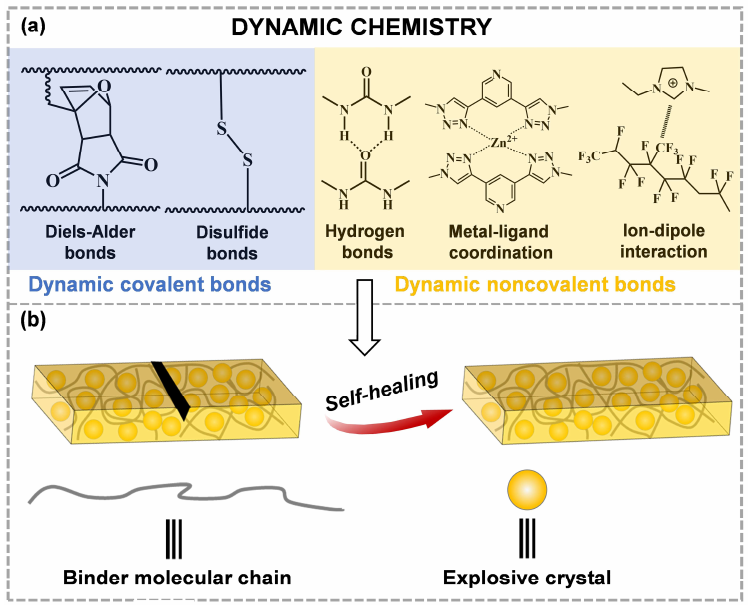
Figure 1. ( a ) Several typical self-healing methods for the crack-healing of ECMs, ( b ) the crack-heal- ing process in ECMs .